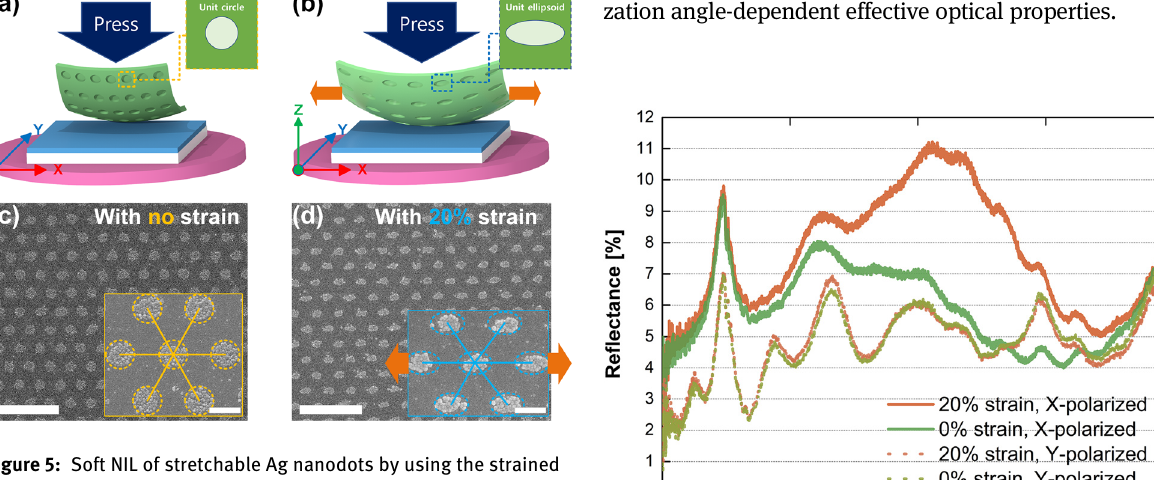
Figure 5: Soft NIL of stretchable Ag nanodots by using the strained PDMS mold. Graphical schematics of soft NIL of the ionic Ag ink performed by using the identical PDMS mold with (a) no strain and (b) 20% strain, respectively. SEM images of the 600H Ag nanodot patterns fabricated accordingly: (c) no strain and (d) 20% strain, respectively. The inset images show the enlarged views of corresponding structures. Scale bars: (c) and (d) 2 µm, (inset) 400 nm.